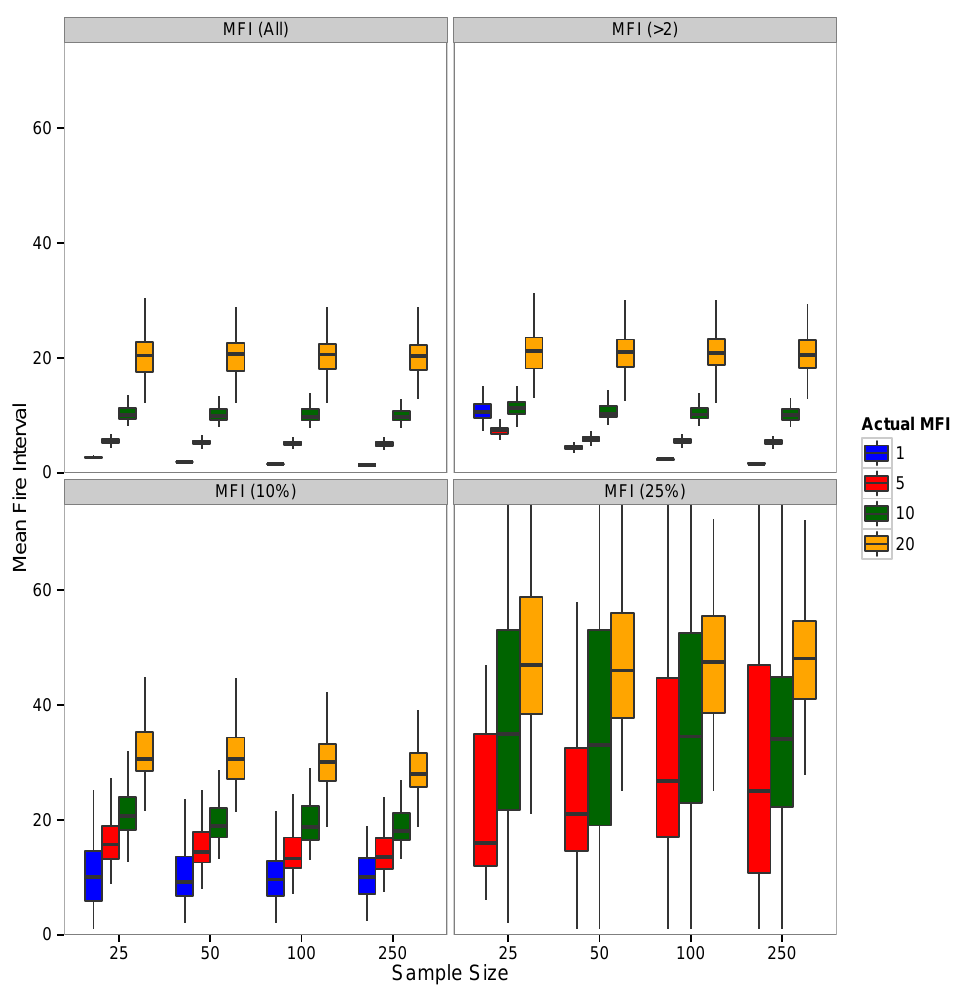
Figure 3. Boxplots of MFI (y-axes) at di ff erent sample sizes (x-axes) for di ff erent levels of filtering for all four fire regimes over 100 simulations each. Note that the four fire regimes are clearly di ff erentiated at 25 samples (0.0625 samples ha − 1 ) in the unfiltered (MFI all ) dataset but are di ffi cult to distinguish reliably in the highly filtered MFI 25%